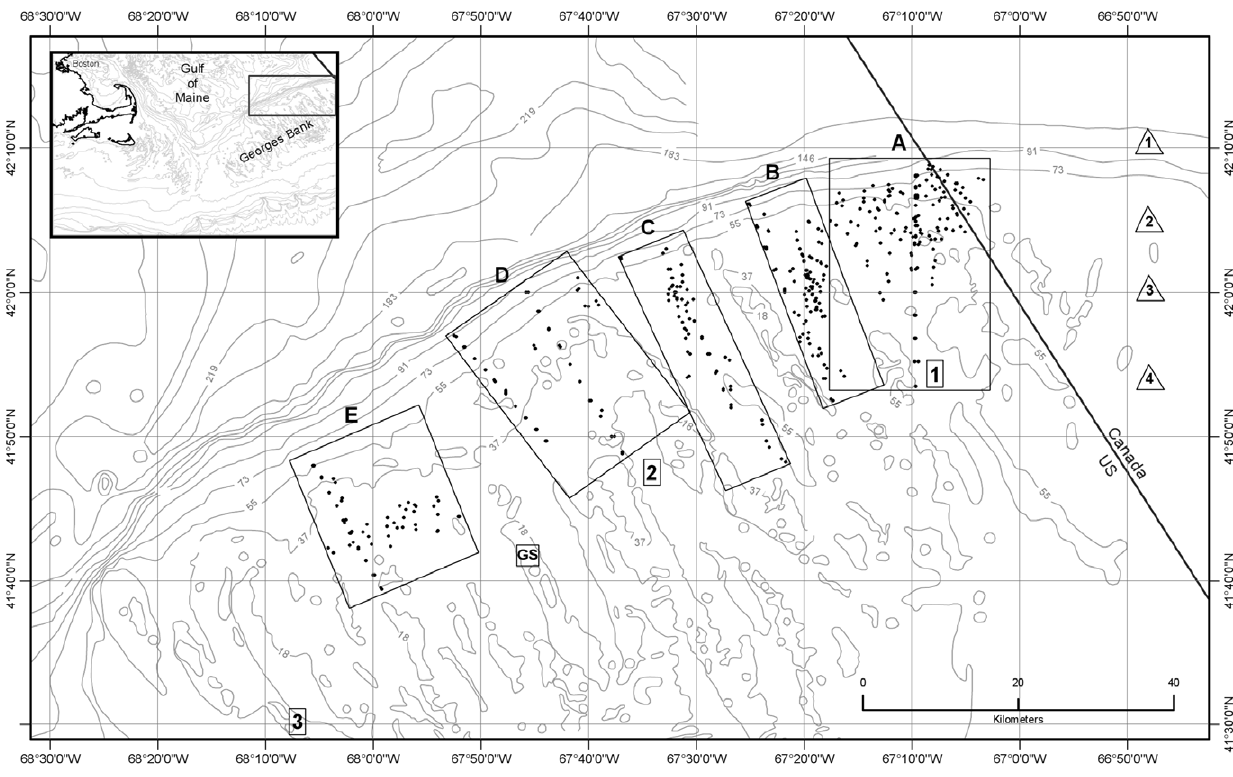
Figure 1. Map showing the location of Georges Bank (inset) and study areas. The locations of study areas A-E (boxes) and 464 seabed temperature stations (dots) occupied in the August 4–13, 2009 time period are indicated. Numbers 1–3 in rectangles mark tidal current prediction sites shown on NOAA Chart 13200 [43]. Numbers 1–4 in triangles mark locations of moored instruments of Loder et al. [18] in July 1988. GS marks location of tidal height predictions on Georges Shoal [42]. Isobaths from NOAA Chart 13200 [43] are labeled in